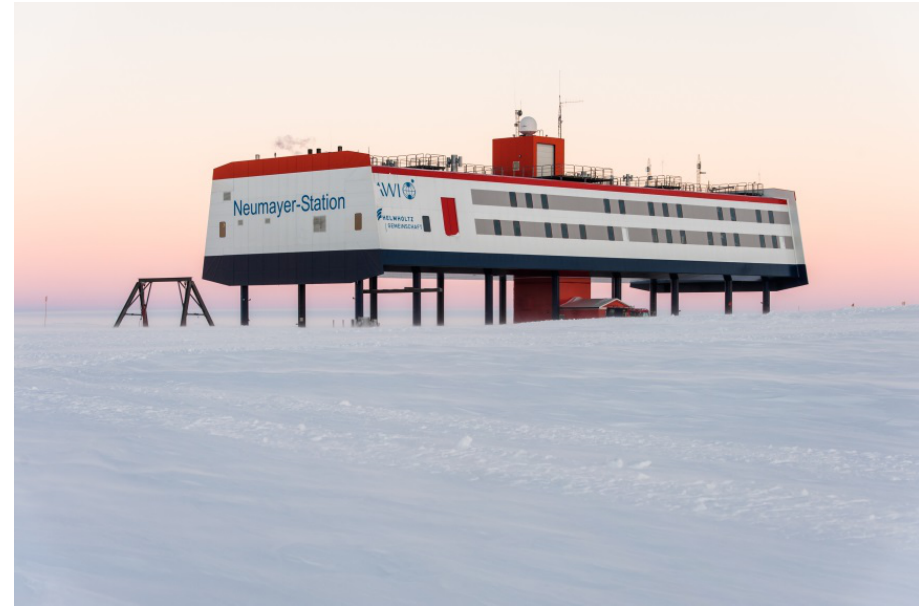
Figure 1: Neumayer III Station. Photo: Alfred-Wegener-Institut/S. Christmann (CC-BY